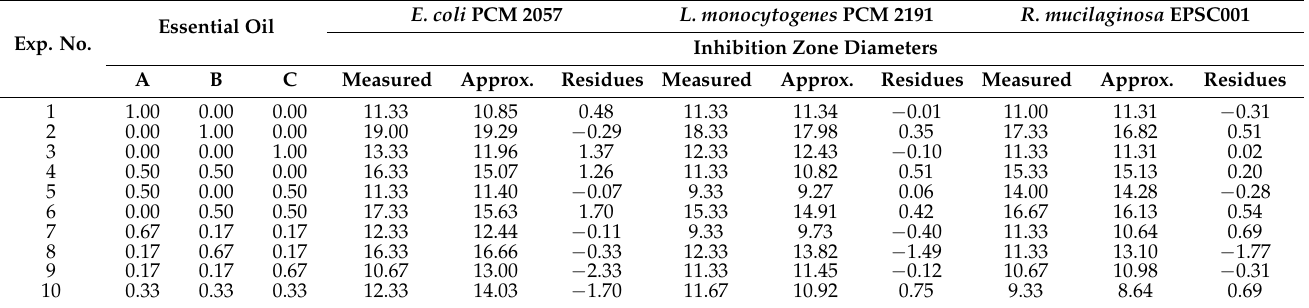
Table 1. Simplex-Lattice Design, experimentally measured inhibition zone diameters, approximated values, and residues for three tested